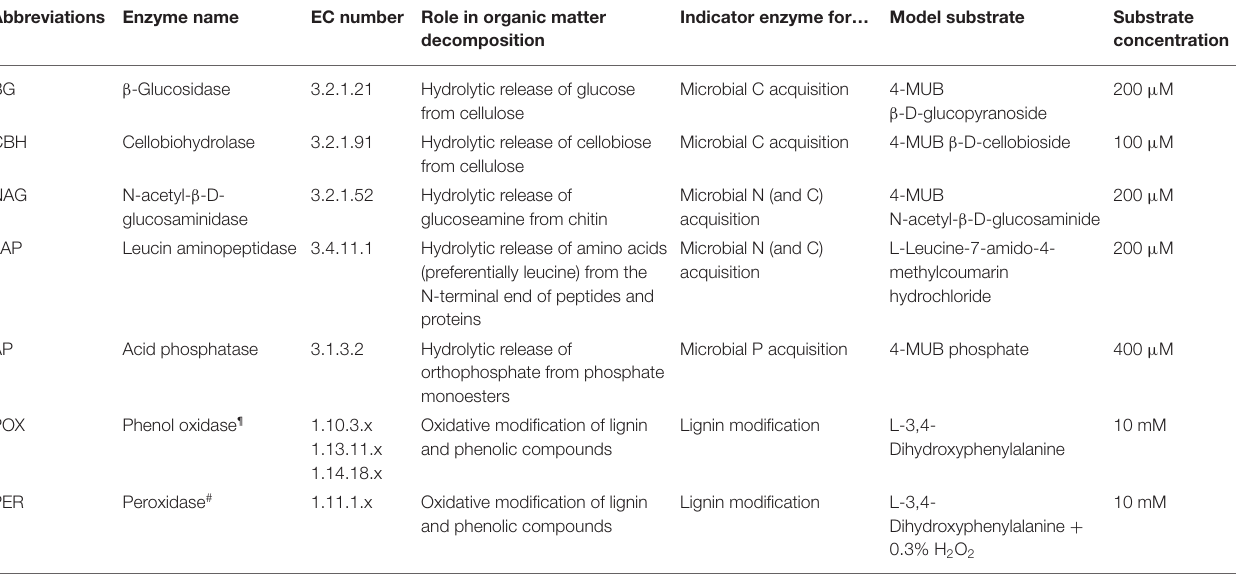
TABLE 2 | Biochemical classification, role in organic matter decomposition and assay details for the seven soil enzyme classes included in this